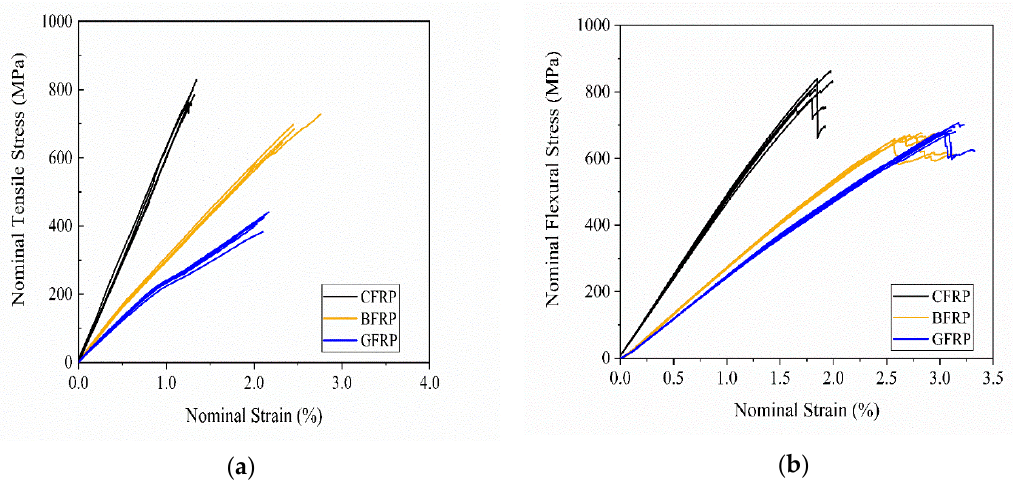
Figure 2. Stress-strain curves of quasi-static tensile ( a ) and flexural ( b ) testing.